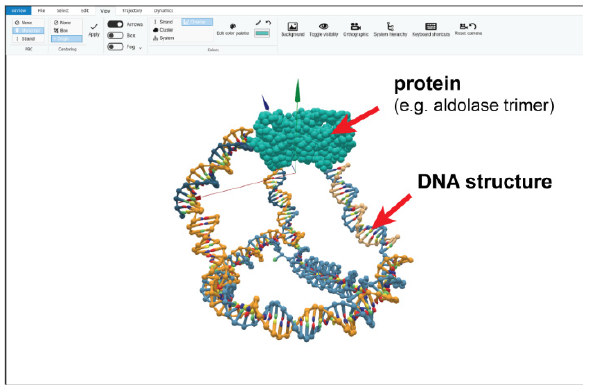
Figure 7. A DNA-protein nanocage as represented in the ANM-oxDNA model using the oxView editing tool. Reprinted with permission from ref. [67], Copyright 2020 Oxford University Press.